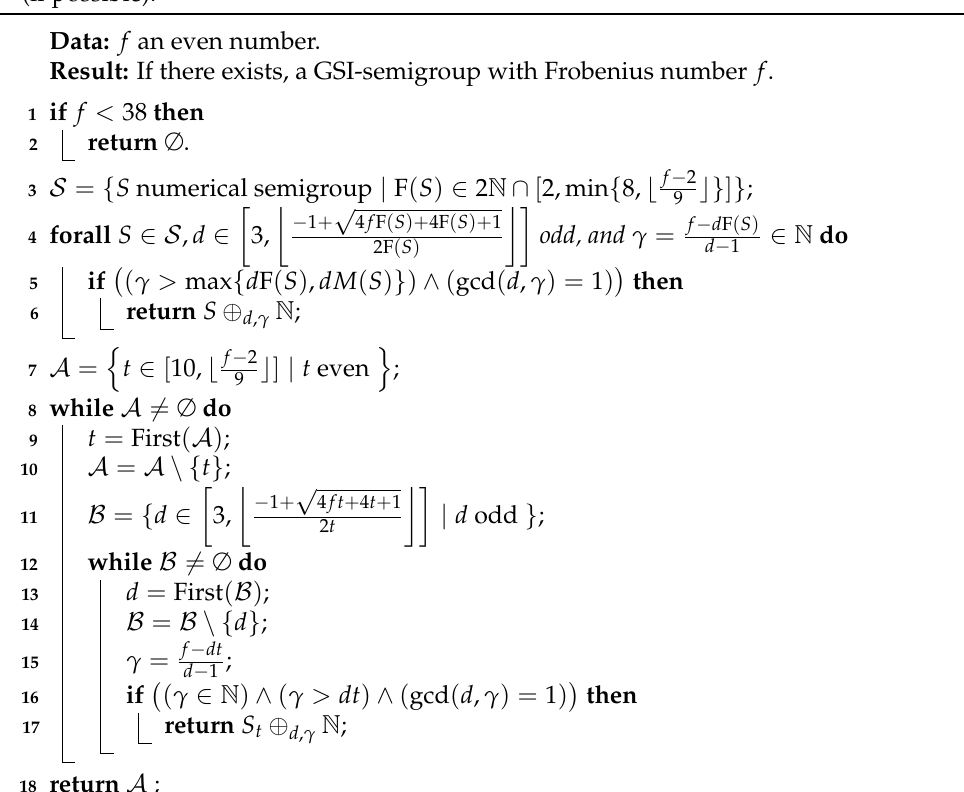
Algorithm 2: Computation of a GSI-semigroup with even Frobenius number